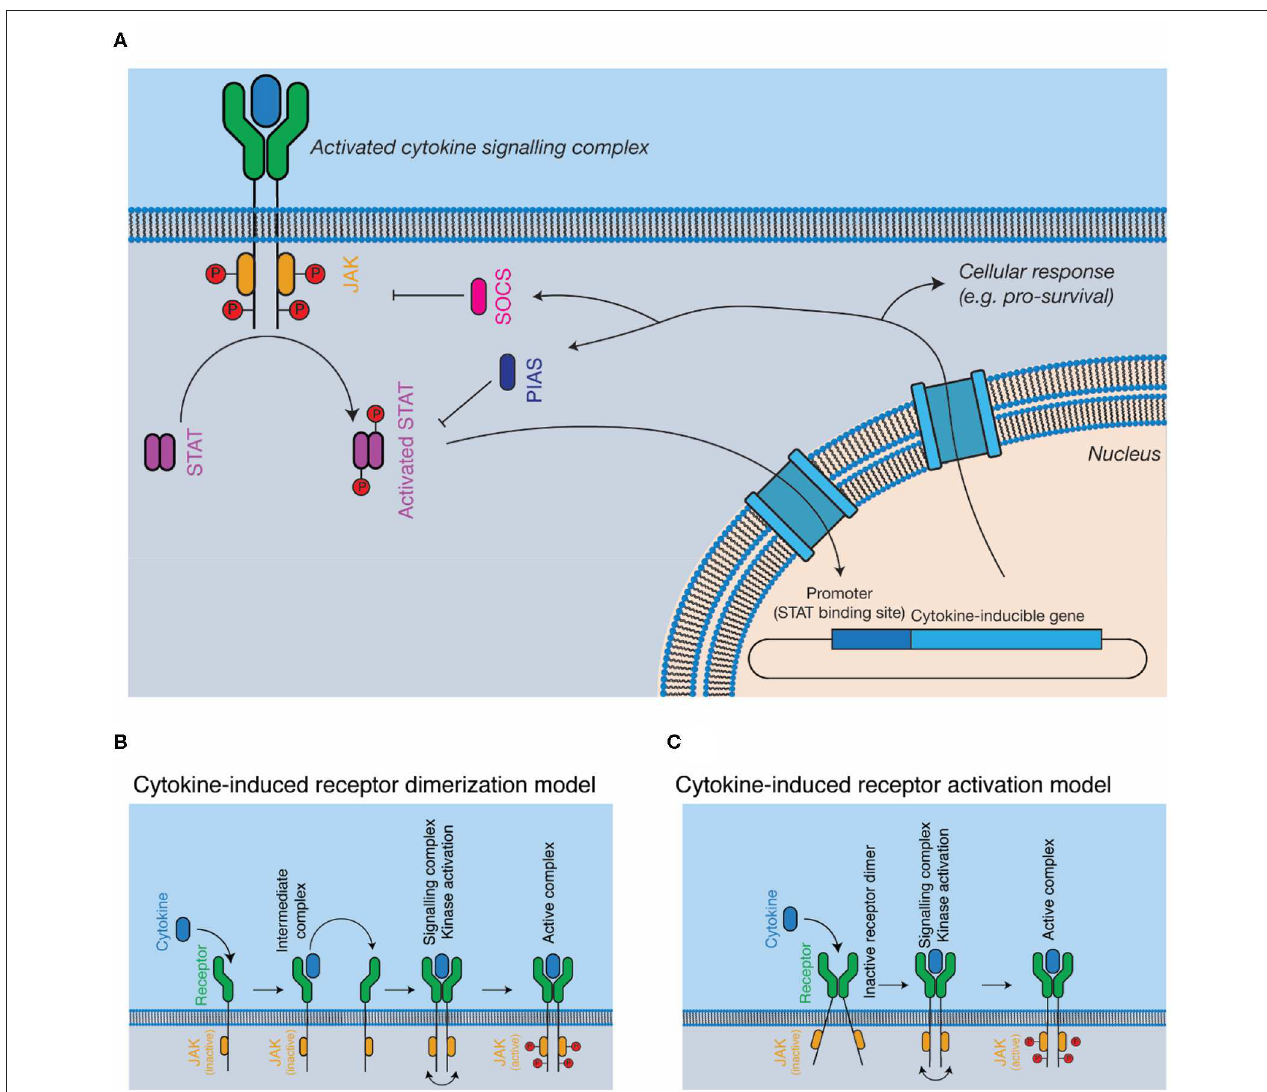
FIGURE 2 | Cytokine signal transduction. (A) General schematic of the JAK-STAT pathway. Cytokine binding results in the activation of intracellular kinases (JAKs) that phosphorylate and activate STATs, which subsequently translocate to the nucleus, resulting in altered gene expression, and negative feedback on the pathway through the SOCS proteins. (B,C) Models for complex activation. Cytokines are thought to either, (B) dimerise receptors on the cell surface, resulting in kinase autophosphorylation and activation or (C) bind to pre-dimerised receptors on the cell surface, resulting in receptor activation through conformational alterations of the receptor